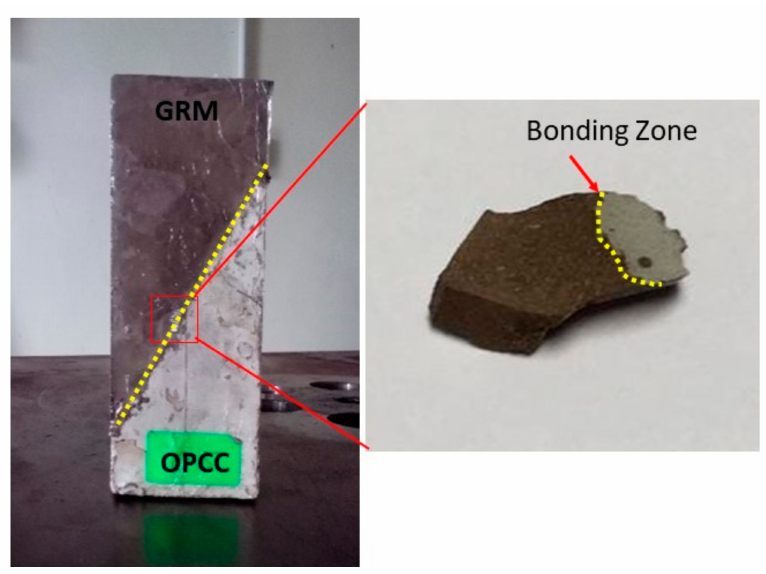
Figure 6. Diagram for the spot area on the sample.